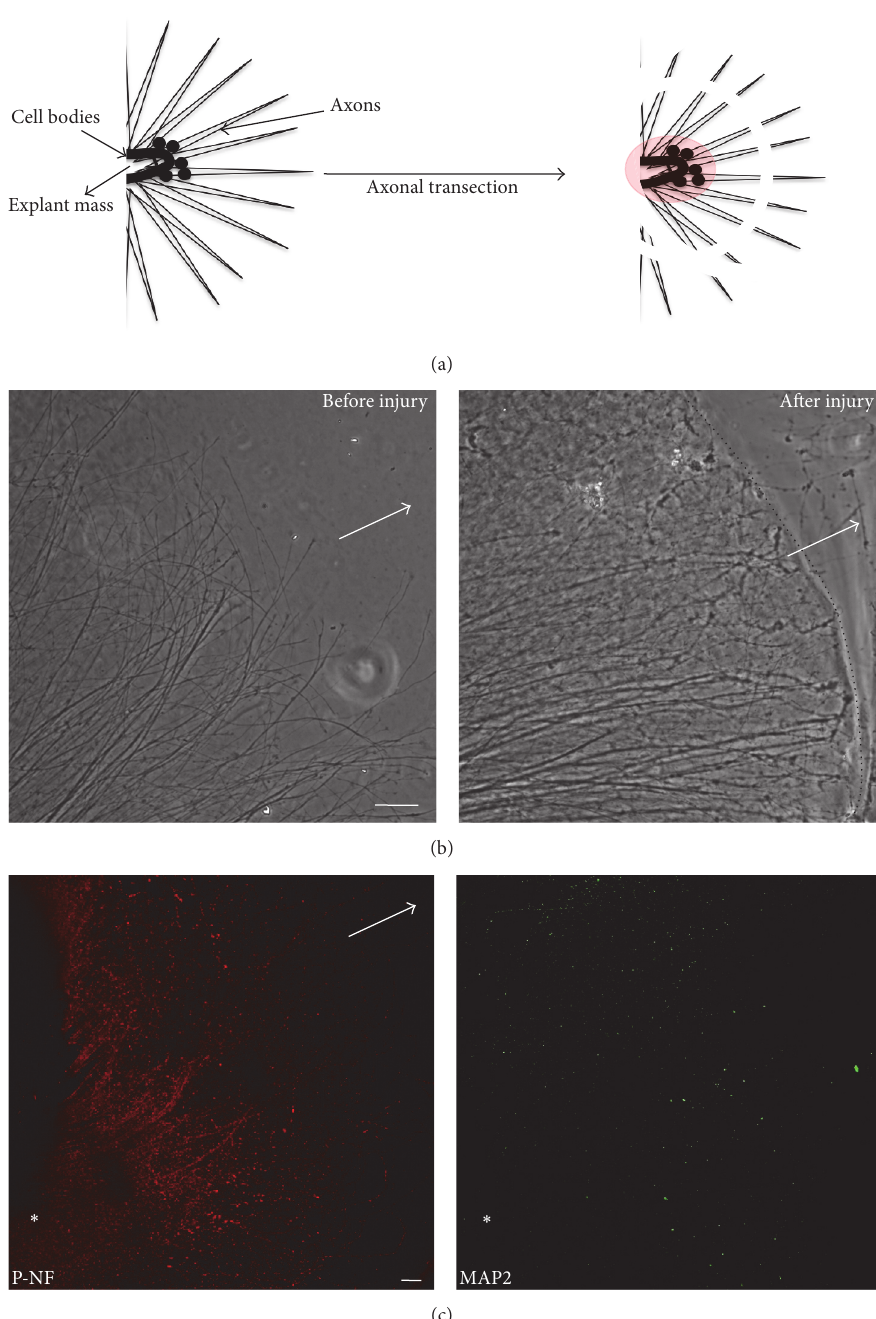
Figure 1: Hippocampal explant injury model. (a) Schematic of axonal injury, performed 2/3 distance away from the edge of the explant. Axons were collected proximal and distal to the injury site. Cell bodies (shaded red) were excluded from collection. (b) Bright-field image illustrating long, narrow axons before and after axonal injury. (c) Double-label immunofluorescence of SMI-31 (red) and MAP2 (green) showed robust axonal outgrowth and very few or no dendrites in the same region (green nonspecific binding). Arrow indicates direction of outgrowth. Asterisk ( ∗ ) indicates explant mass. Additional details of explant system are provided in [20]. Bars are 75 𝜇 m.